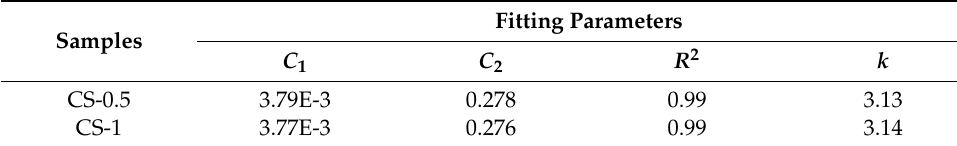
Figure 11. C-damage intensity curves based on LAS test. Figure 11. C ‐ damage intensity curves based on LAS test. Table 9. Fitting Table 9. Fitting parameters.